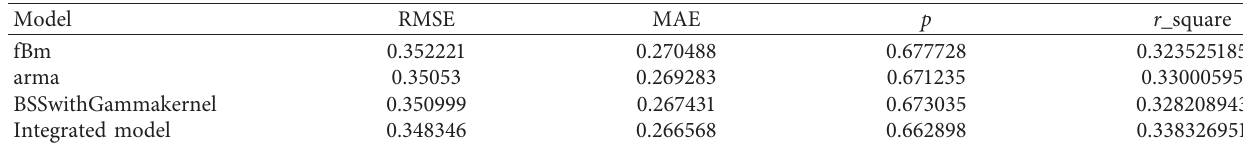
Table 22: Error evaluation of three volatility prediction models and their integrated models.